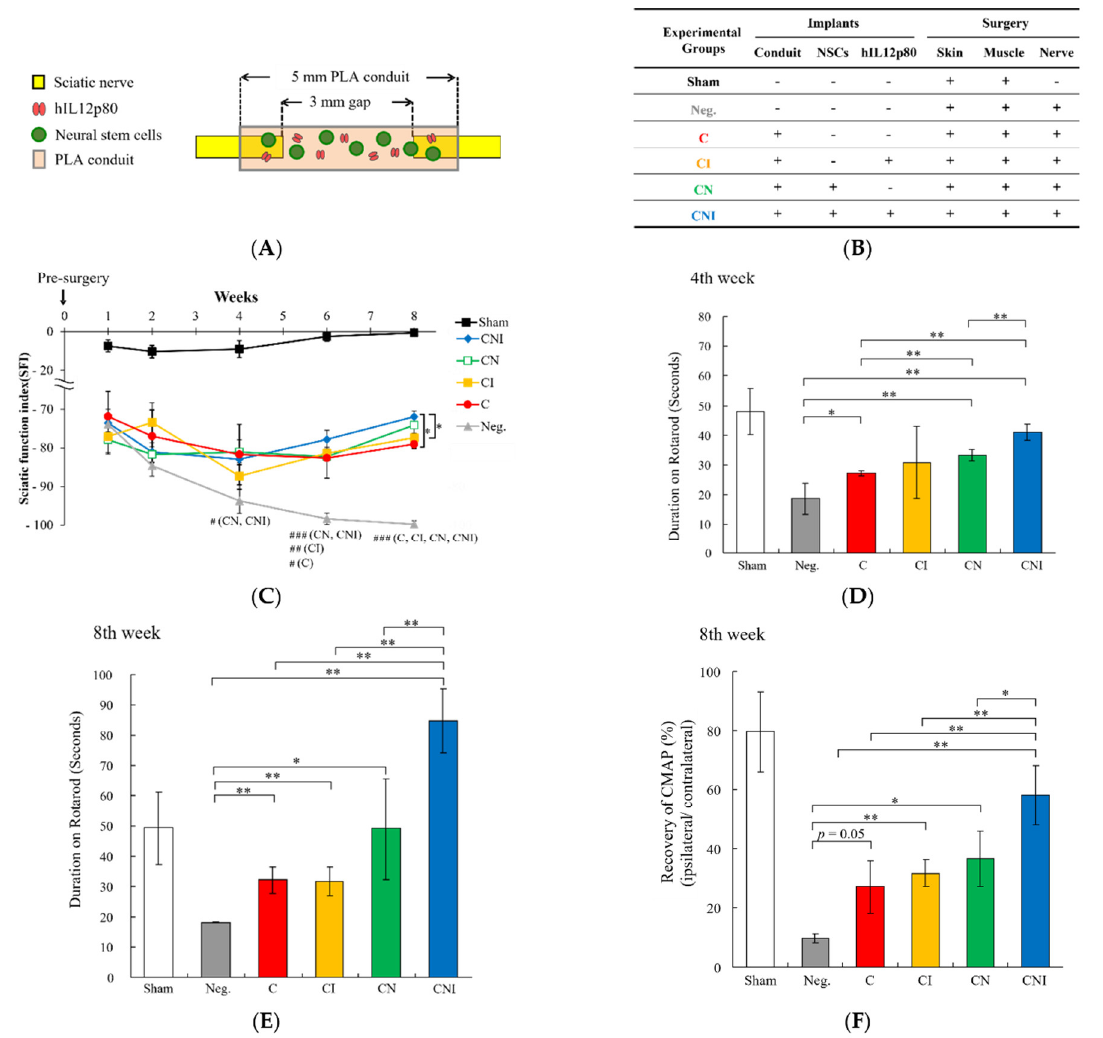
Figure 1. Implantation of a conduit with NSCs and human IL12p80 improves functional recovery and nerve conduction in sciatic nerve injury mice. ( A ) Schematic diagram and illustration of implanted PLA conduit, filled with matrix gel, NSCs, and hIL12p80. ( B ) Description of different experimental groups treated with or without the implants of conduit, NSCs, and hIL12p80 and with or without the surgery of skin, muscle, and nerve of a mouse model. ( C ) Sciatic functional index (SFI) was calculated to assess the functional recovery of sciatic nerves. The hashtag (#) indicated that, beginning at the fourth week, the four different treatment groups showed a progressively significant difference